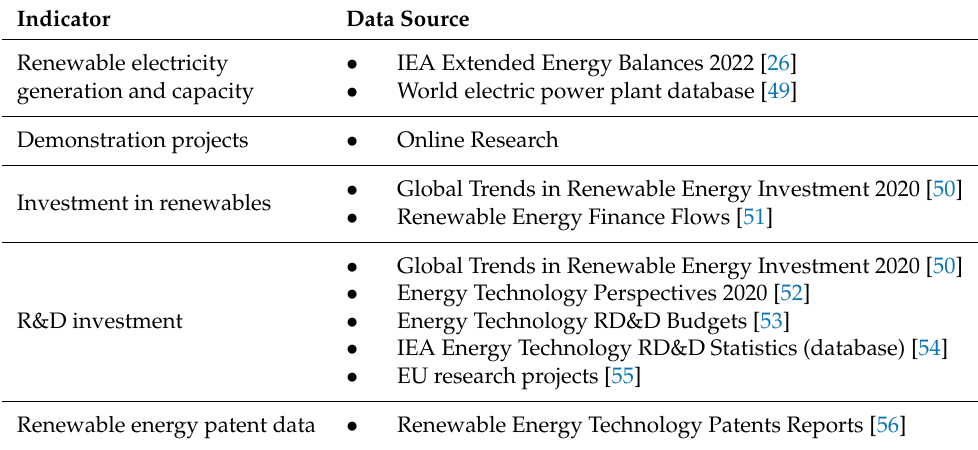
Table 1. Main data sources used per